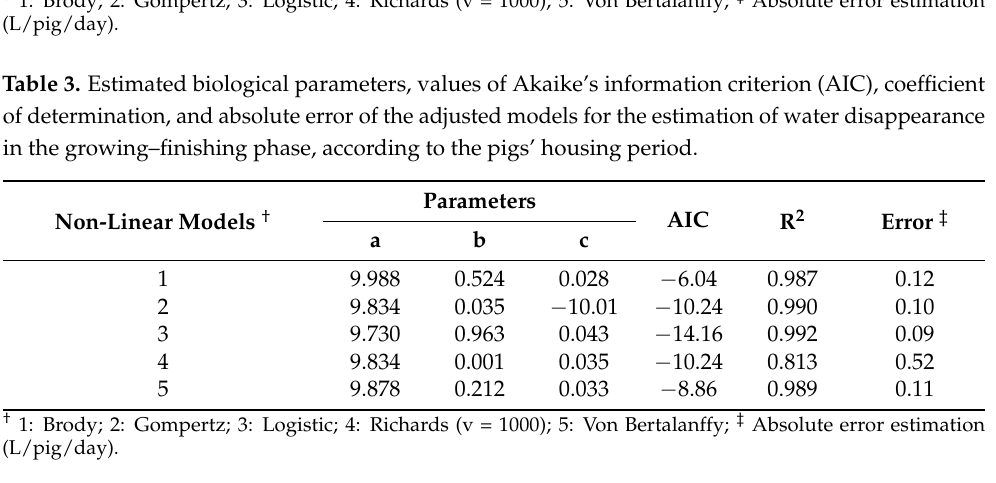
Table 4. Estimated biological parameters, values of Akaike’s information criterion (AIC), coefficient of determination, and absolute error of the adjusted models for the estimation of manure production in the growing–finishing phase, according to the pigs’